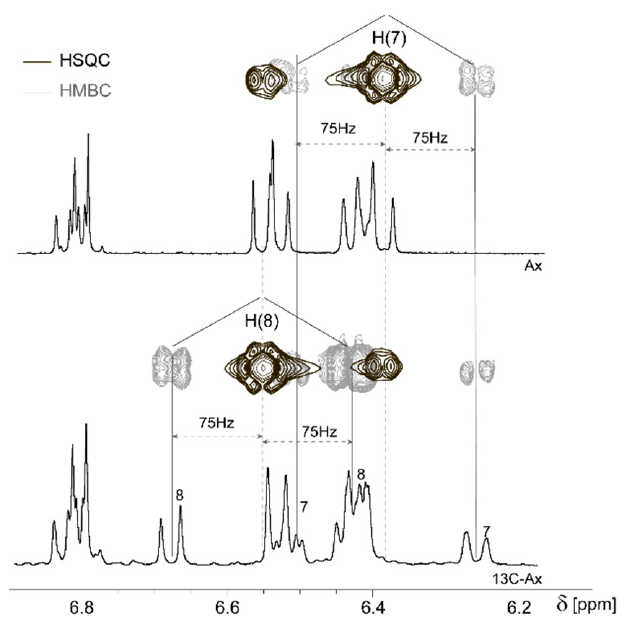
Figure 2. One-dimensional (1D) 1 H and two-dimensional (2D) 1 H- 13 C HSQC (black) and 1 H- 13 C Figure 2. One ‐ dimensional (1D) 1 H and two ‐ dimensional (2D) 1 H ‐ 13 C HSQC (black) and 1 H ‐ 13 C HMBC HMBC (gray) spectra of 13 C-enriched astaxanthin (13C-Ax) at 300 K. Ax-1D 1 H NMR spectrum of (gray) spectra of 13 C ‐ enriched astaxanthin (13C ‐ Ax) at 300 K. Ax ‐ 1D 1 H NMR spectrum of natural natural astaxanthin. δ —chemical shift in ppm. astaxanthin. δ —chemical shift in ppm.